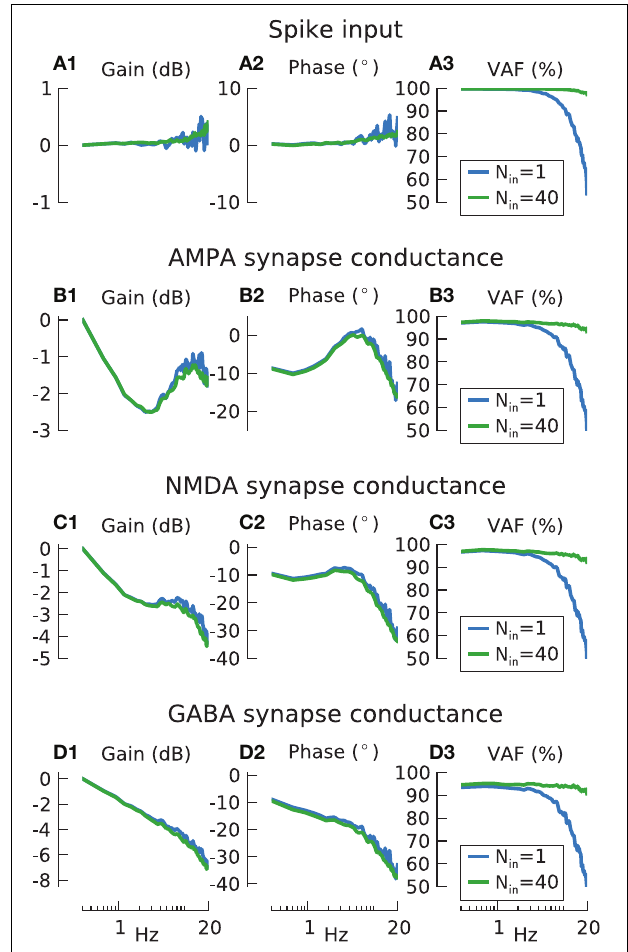
FIGURE 6 | Information transmission by input spike train encoder and synaptic conductances. (A) Transfer function gain (A1) and phase (A2) for input spike trains produced by ideal integrate-and-fire (IF) neurons (blue lines N = 1, green lines N in = 40), with input carrier-rate F 0 in = 40 spikes/s and modulationamplitude a = 1stimulatedby20Hzlow-passfilteredwhitenoise. Gainvaluesarenormalizedtothelowestfrequencyfortheresultsfrom N = 1. (A3) shows variance accounted for. The mean % VAF is 85.9 for N = 1, 99.1 for N = 40. (B) Asin (A) ,butwiththespike-trainoutputoftheidealIFneurons additionallypassedthroughmodelAMPAsynapses.ThemeanVAFis80.7for N = 1, 96.1 for N = 40. (C) As in (B) , but for model NMDA synapses. The mean % VAF is 79.8 for N = 1, 95.3 for N = 40. (D) As in (B) , but for model GABA synapses. The mean % VAF is 76.9 for N = 1, 93.7 for N =